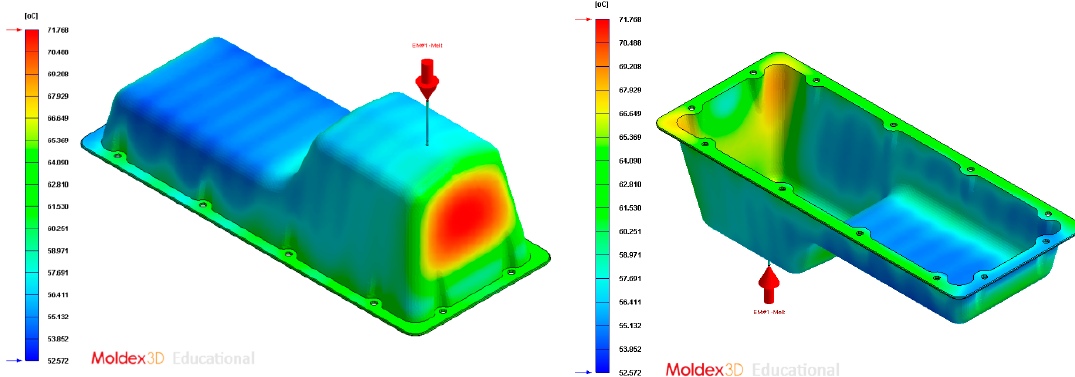
Figure 30. Average temperature (°C) on the surface of the plastic part after the cooling phase, Case C. Front view ( left ) and bottom view ( right ).